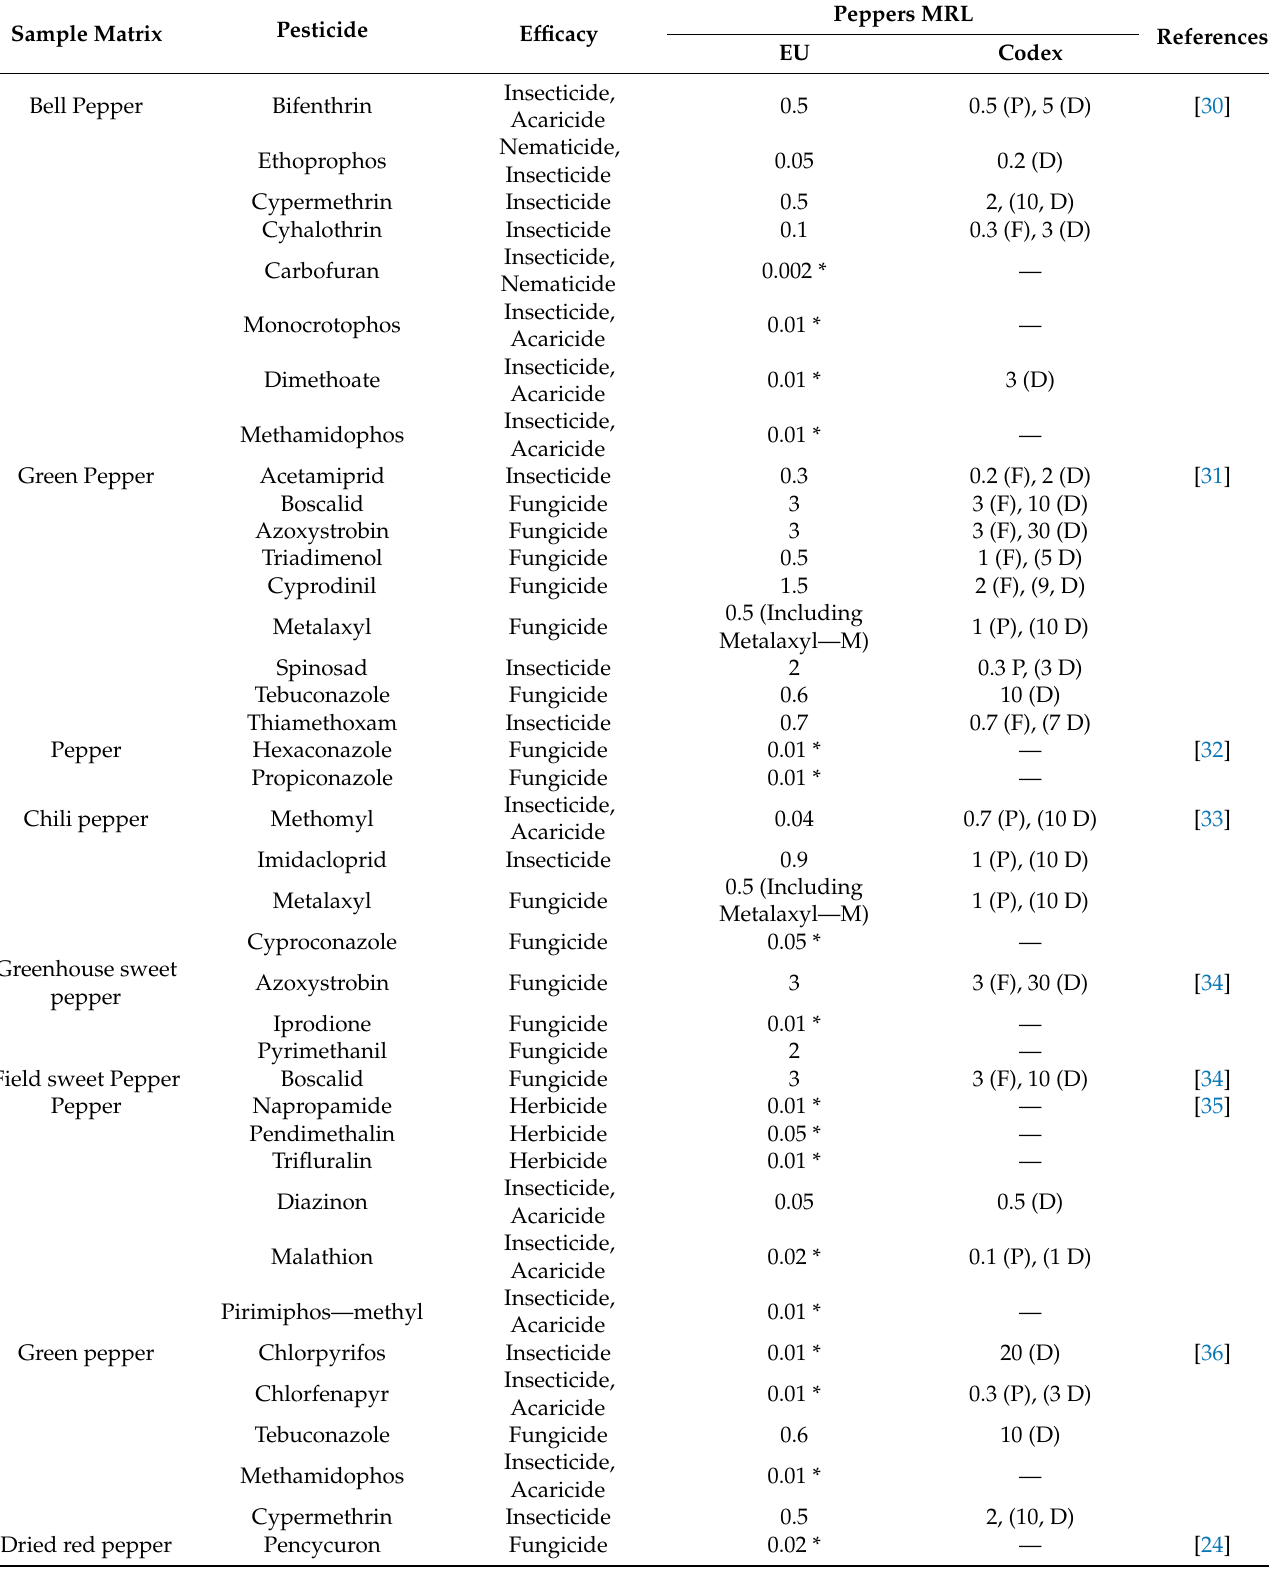
Table 1. Pesticide levels of peppers in which the maximum residue limits (MRLs) were